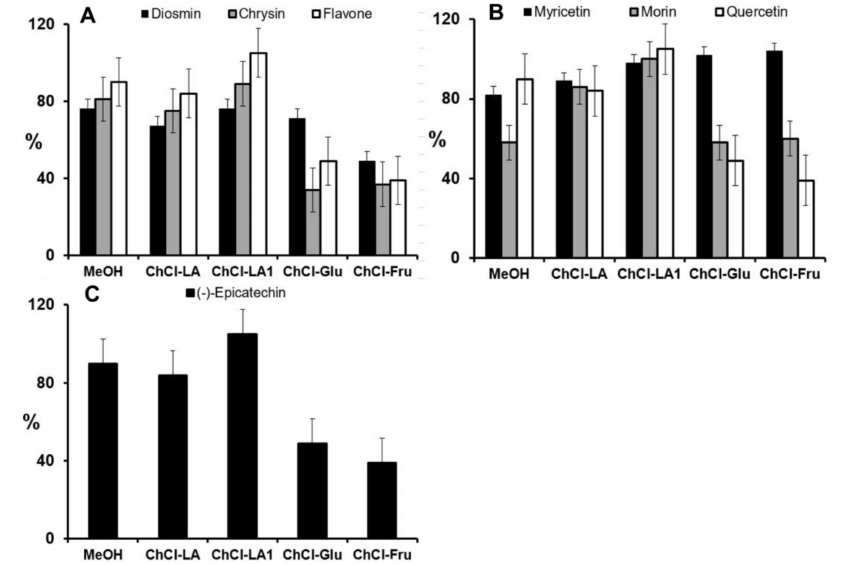
Figure 3. Extraction recoveries of spiked samples (%) for analysed flavonoids (( A )-flavones; ( B )-flavonols; ( C )-flavanol) obtained after extraction with 80% MeOH and after extraction with di ff erent